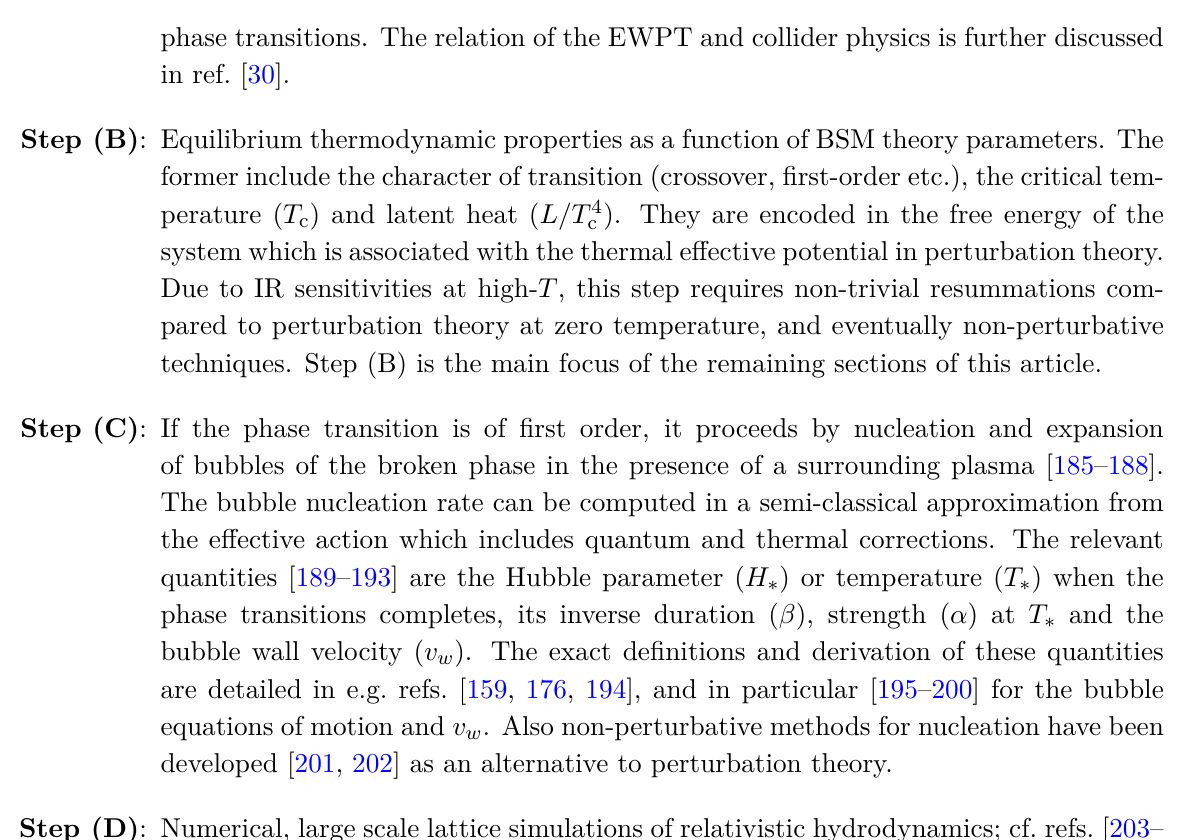
Figure 1 . A pipeline between collider phenomenology of BSM theory and stochastic gravitational wave background signature. Later we focus on step (B), as even relatively small uncertainties in this step can propagate all the way down the pipeline and cause significant errors in the